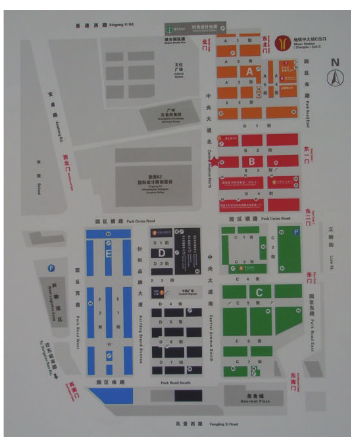
Figure 7: Layout of Xingang 82.